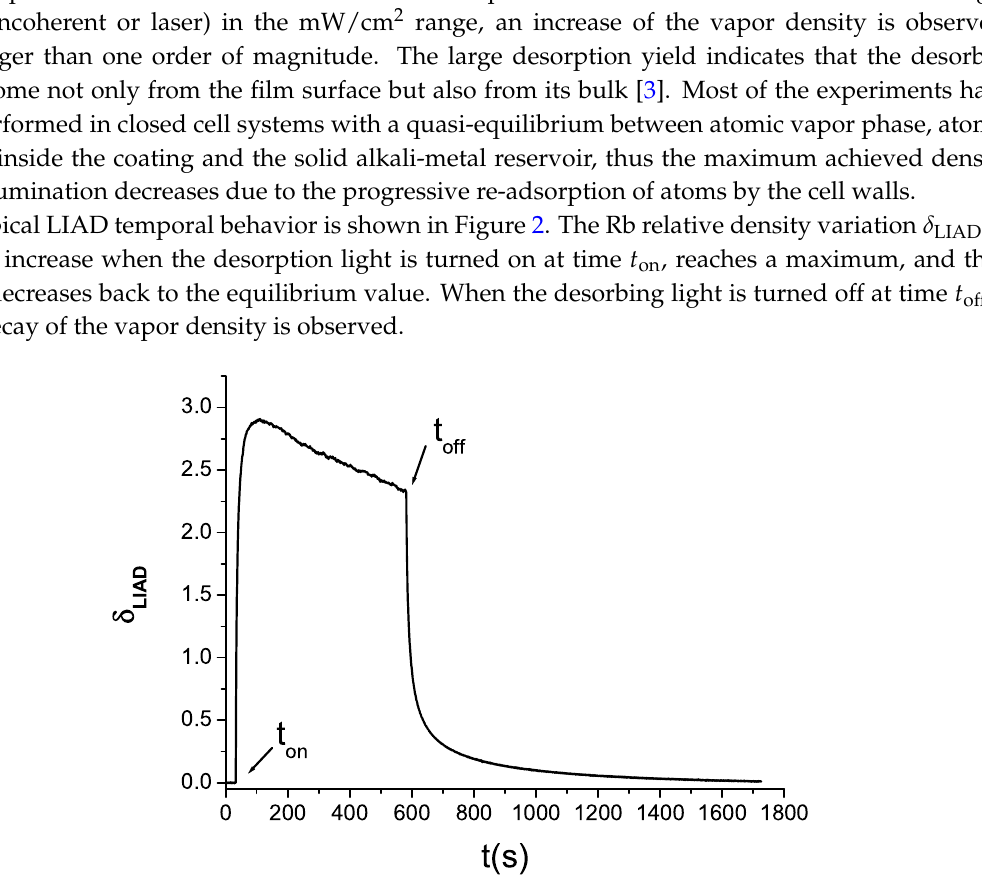
Figure 2. Typical example of an LIAD (Light Induced Atomic Desorption) signal: Rb relative vapor density variation as a function of time in a polydimethylsiloxane (PDMS) coated cell. t on and t off indicate the time when the desorption light ( I L = 17 mW/cm 2 at 514 nm) is turned on and